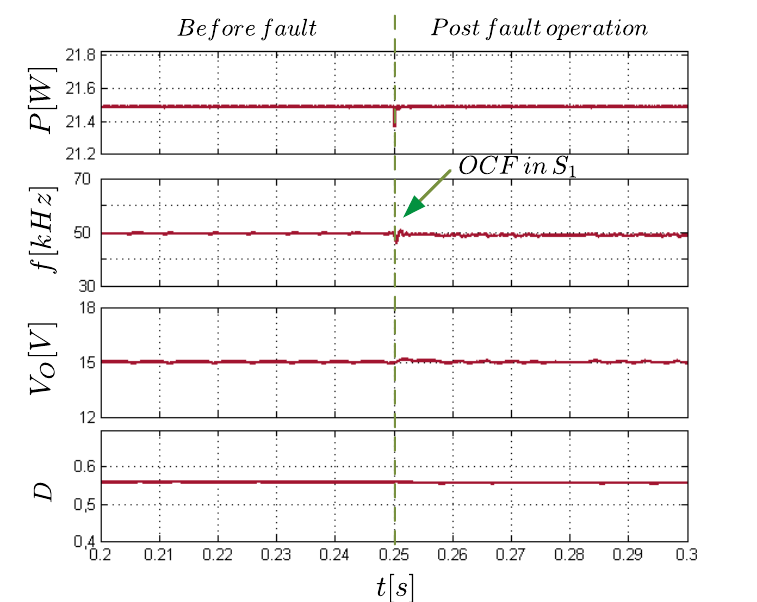
Figure 14. Open Circuit Fault (OCF) in the switch S 1 at t = 0.25 s; from the top to the bottom P , f , V O and D